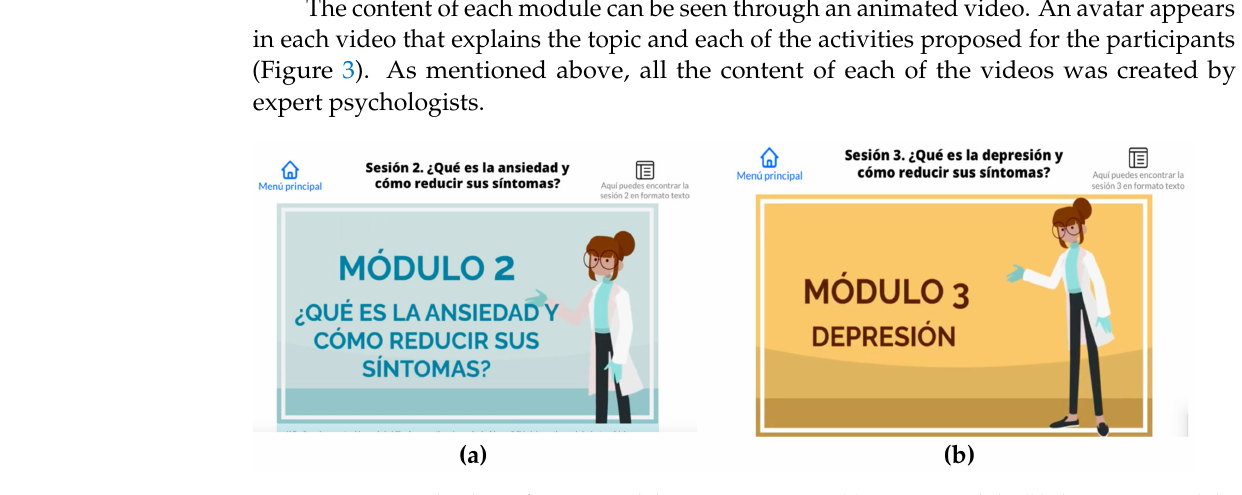
Figure 3. Animated videos of anxiety and depression sessions. ( a ) anxiety module; ( b ) depression